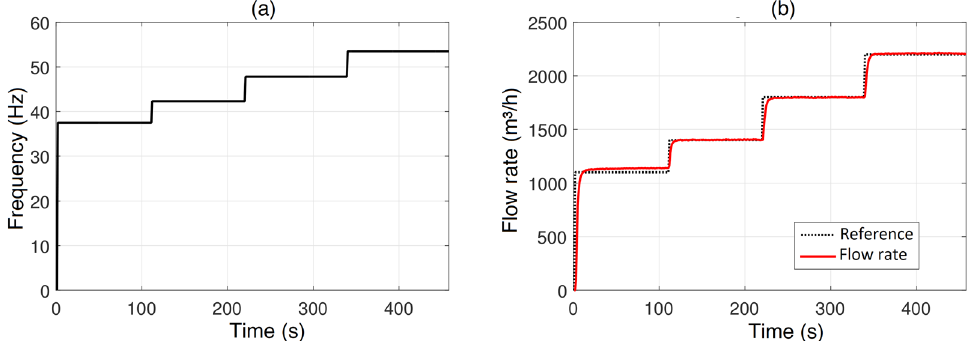
Figure 2. Experiments, curves, using the open loop pumping system to analyze a relation between motor frequency type changes and leakage variation.